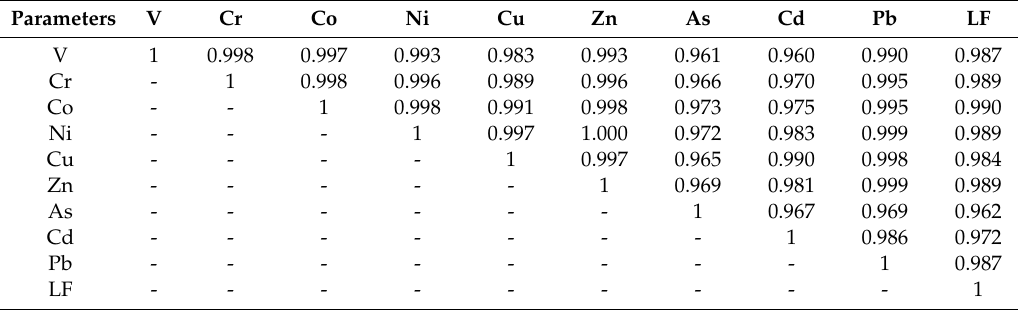
Table 3. Pearson correlation coe ffi cients (r) among the low-frequency magnetic susceptibility (LF)